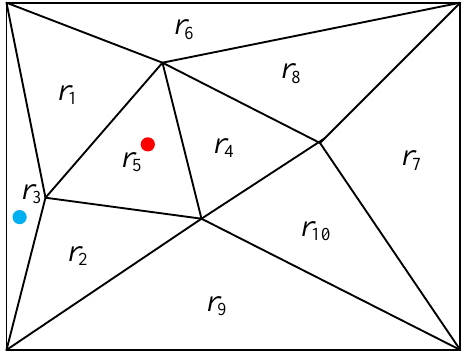
Figure 1. A simple MTRS for examples 1 and